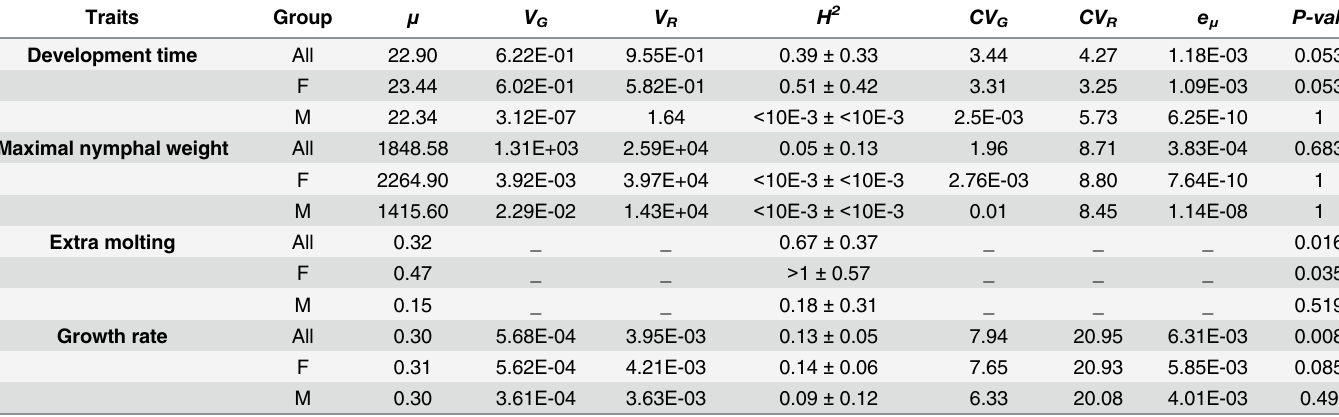
Table 3. Genetic parameters of each trait of nymphal development in S . gregaria